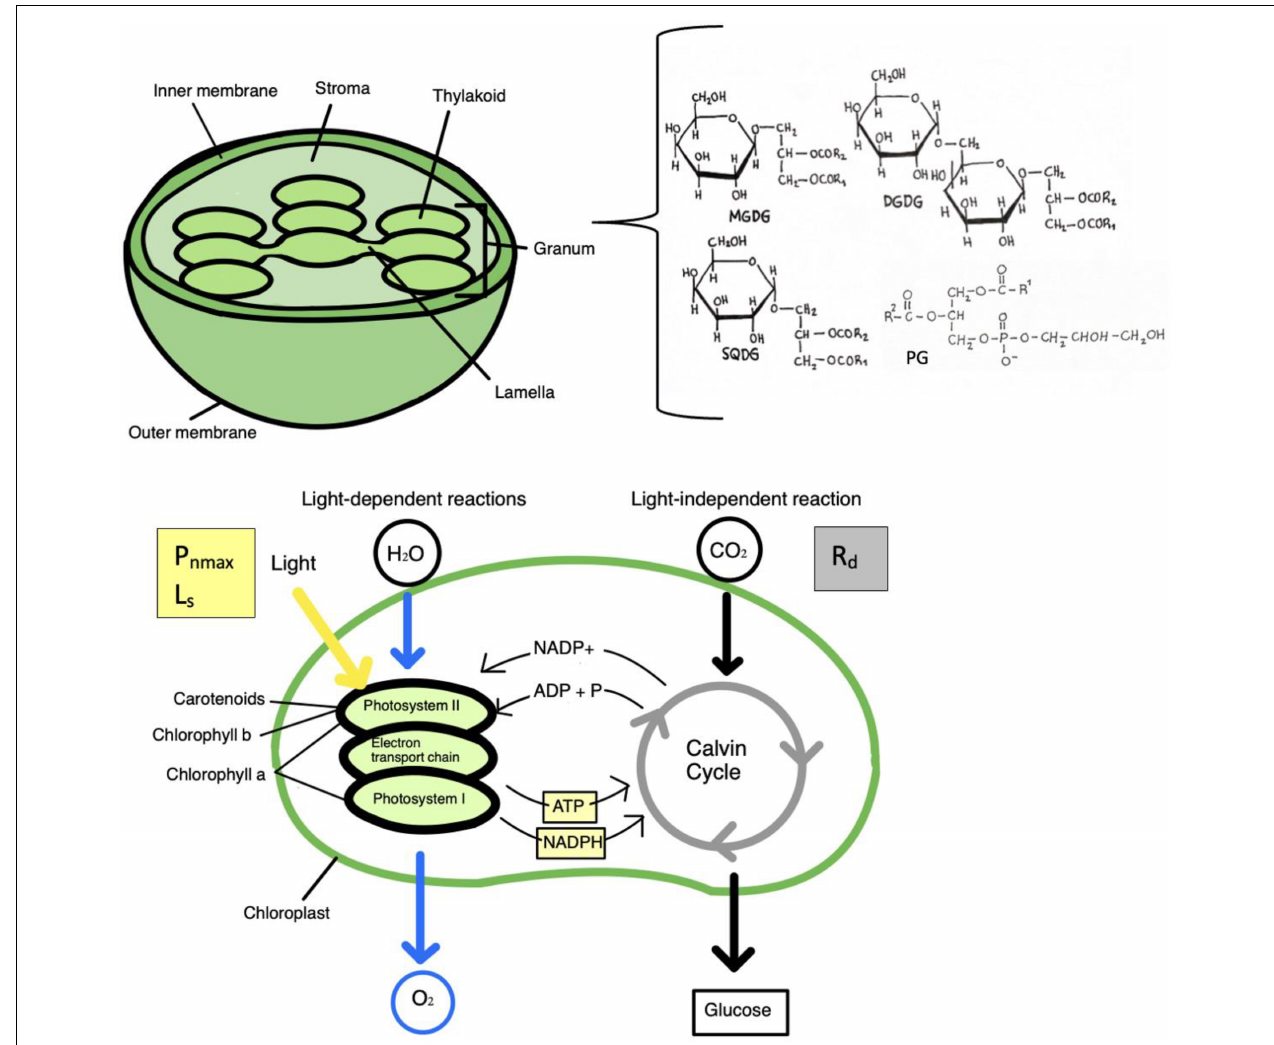
FIGURE 2 | The three glycerolipids monogalactosyldiacylglycerol (MGDG), digalactosyl diacylglycerol (DGDG), and sulfoquinovosyldiacylglycerol (SQDG), are found exclusively in the chloroplast membrane, and in higher plants, the thylakoid membrane consists of MGDG, DGDG, SQDG and phosphatidylglycerol (PG). Alterations in the content of these lipids could impact properties of photosynthetic membranes. Therefore, these glycerolipids may play a role in photosynthetic stress response. The photosynthetic pathway is illustrated, with the light dependent and independent (dark) reactions. Chlorophyll a is found in the reaction centers of photosystems I and II, while chlorophyll b and carotenoids are accessory pigments in the pigment antenna. Photosynthetic parameters are a measure of photosynthesis. Photosynthesis light saturation point (L s ) and net maximum photosynthetic rate (P nmax ) are a measure of light-saturated photosynthesis, while dark respiration rate (R d ) is respiration in the absence of